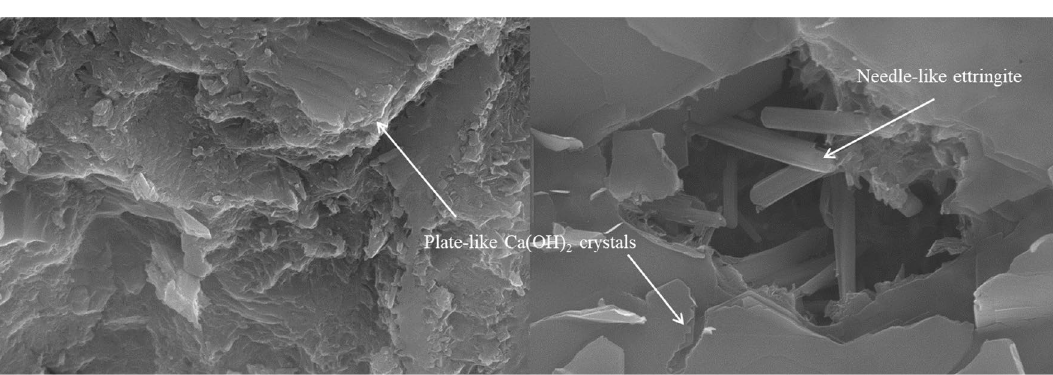
Figure 13. SEM images of ordinary cement mortar specimens cured for 28